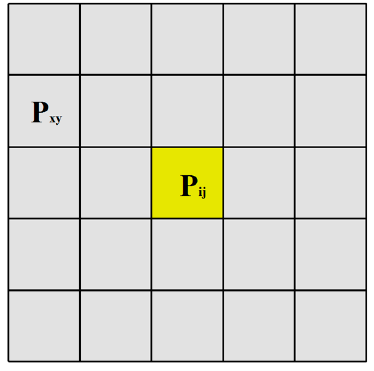
Figure 4. K*K neighborhood O n